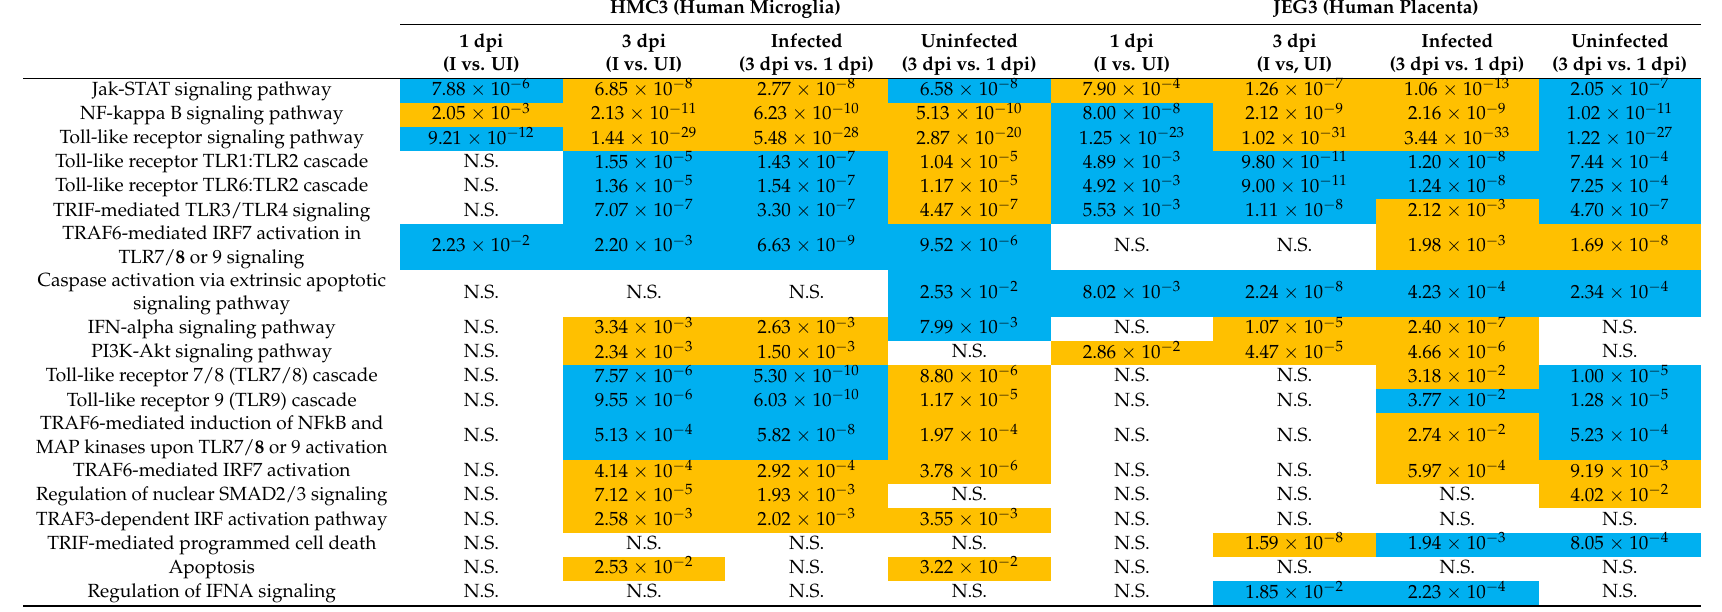
Table 1. Bonferroni-corrected p -values of differentially affected signaling pathways detected with the signaling pathway impact analysis (SPIA) algorithm in: ZIKV-infected (I) or time-matched mock-infected (UI) cells at each of two time points in each cell